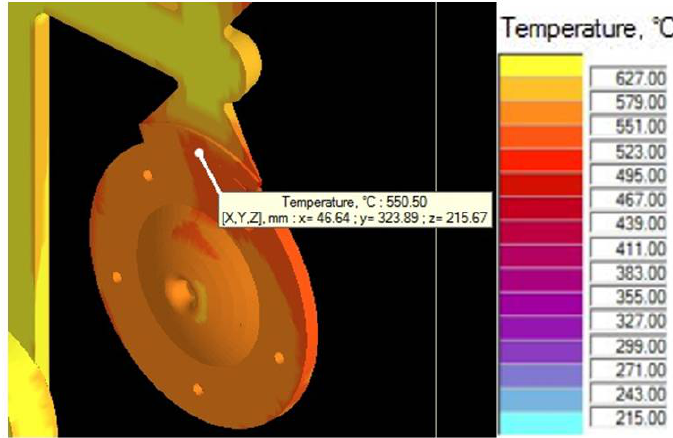
Figure 11. Temperature in the ingate.